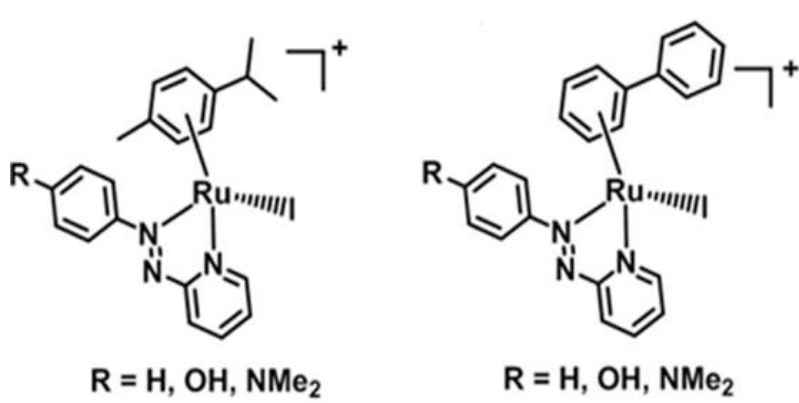
Figure 13. Structures of ruthenium complexes synthesized in this work [84].